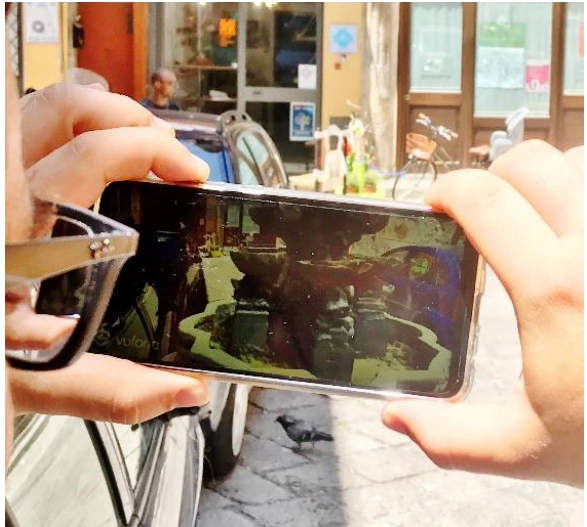
Figure 12. The testing of the outdoor AR experimentation: the 3D virtual model of the Garraffo fountain appears in the real environment of Piazza Garraffo, in correspondence with its original location.